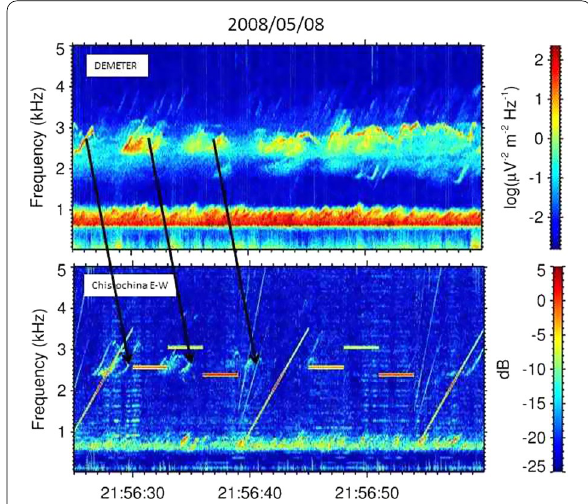
Fig. 17 Zoom of Fig. 15. Comparison between the spectrograms recorded by DEMETER in the Southern hemisphere (top panel), and recorded at Chistochina (bottom panel). The power spectral density is color-coded according to the scale on the right. The black arrows indicate the correspondence between bursts of triggered emissions seen at Chistochina and the same bursts of triggered emissions observed by DEMETER